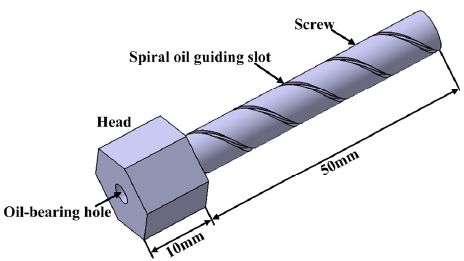
Metals 2023 , 13 , x FOR PEER REVIEW Figure 1. The bolt with an oil-bearing hole and spiral oil-guiding slot. Figure 1. The bolt with an oil-bearing hole and spiral oil-guiding slot.